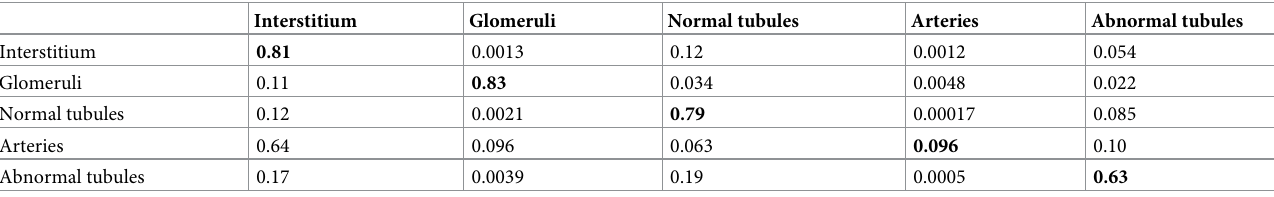
Table 4. Confusion matrix for five-class segmentation using